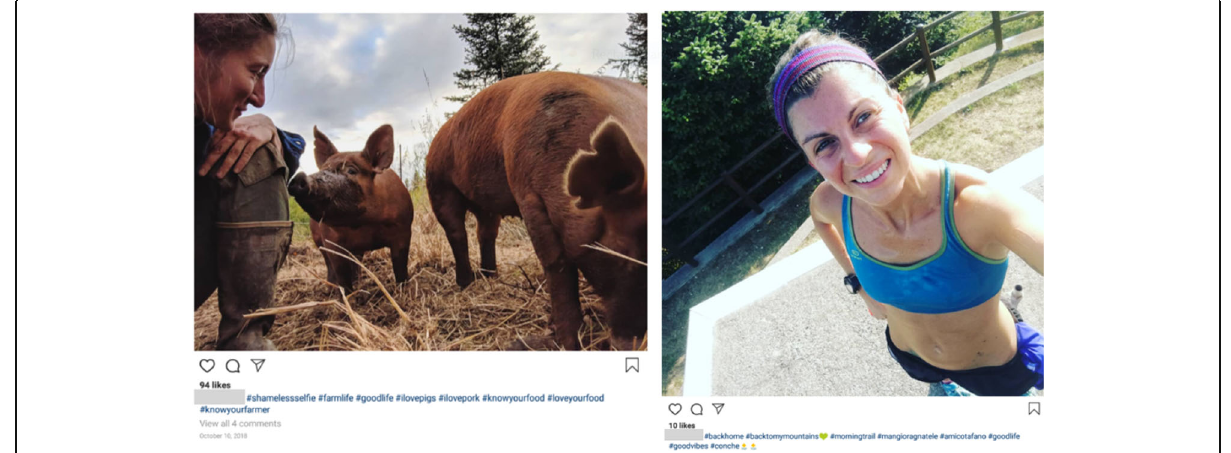
Fig. 3 Two posts illustraying the good life narrative as shared